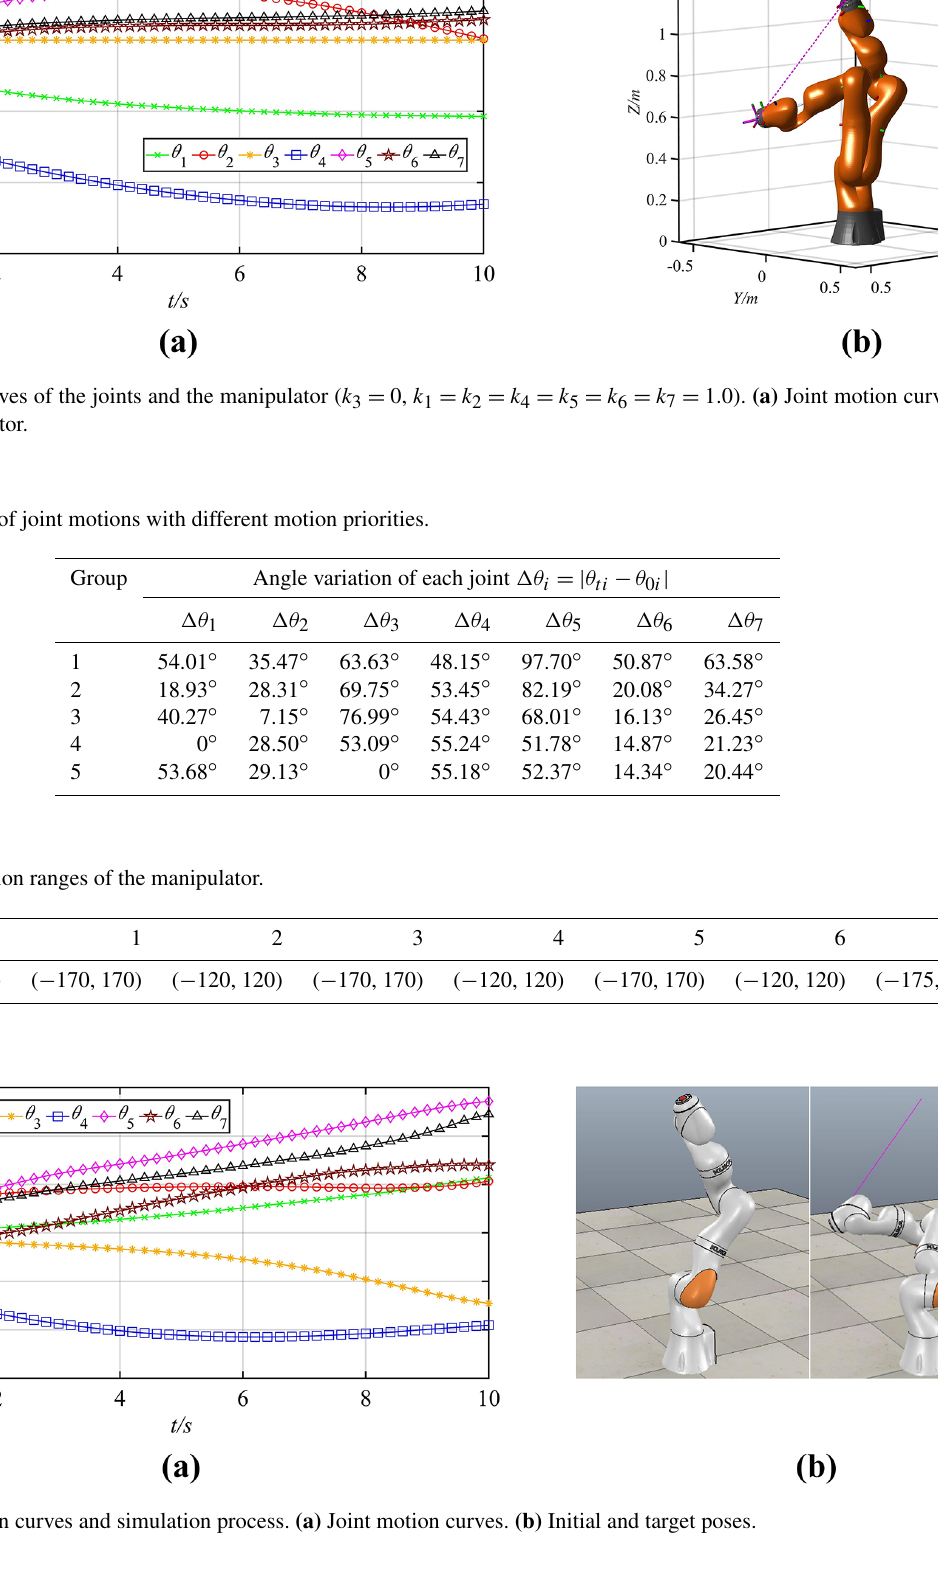
Mech. Sci., 12, 221–235,